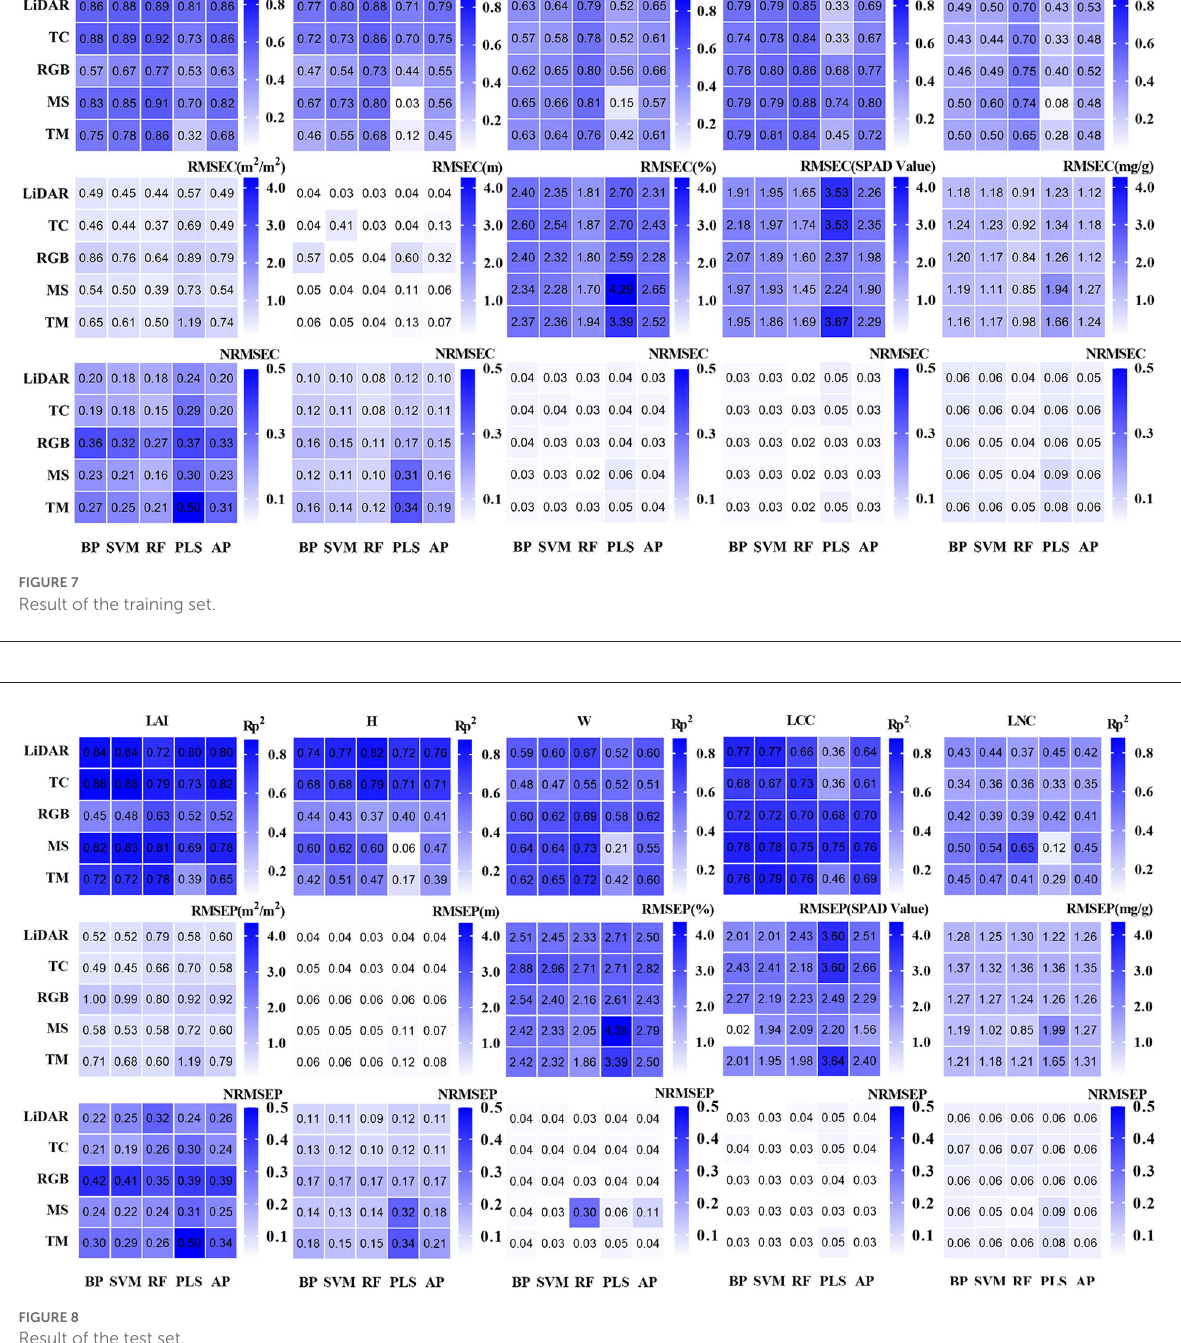
FIGURE8 Result of the test set.